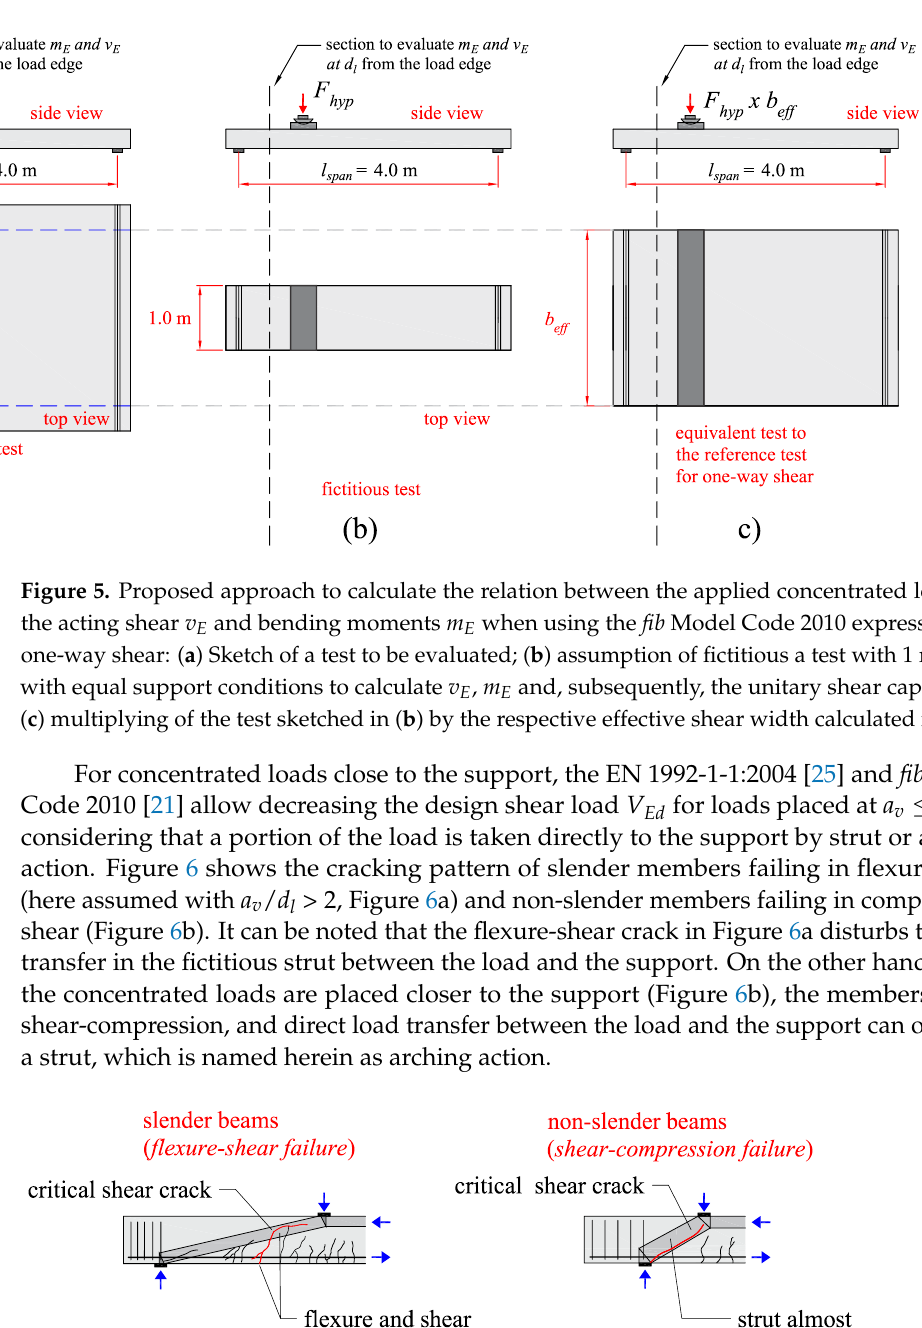
Figure 6. Influence of the shear slenderness (here defined as a v / d l ) in the cracking pattern and failure mechanism of members loaded over the entire width: ( a ) slender beams failing in flexure-shear; ( b ) non-slender beams failing in shear-compression (adapted from Muttoni and Fernandez Ruiz [17]).